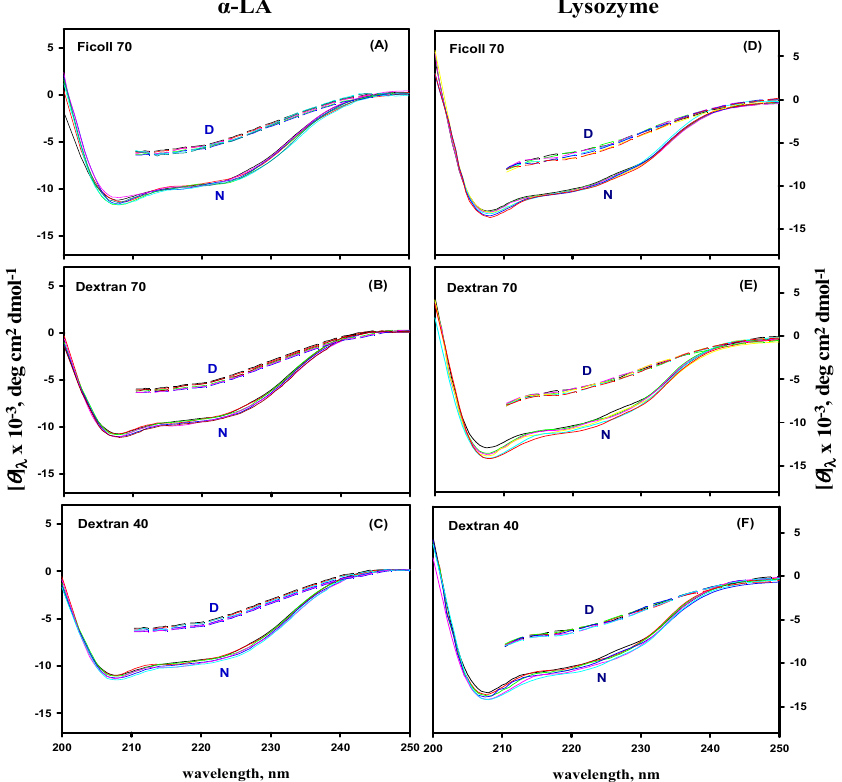
Figure 5. The far-UV CD spectra of the native and denatured states of α -LA (panels A – C ) and lysozyme (panels D – F ) in the absence and presence of different concentrations of ficoll 70, dextran 70, and dextran 40 at pH 7.0. N and D in each panel represent the native and denatured states of both the proteins, respectively.